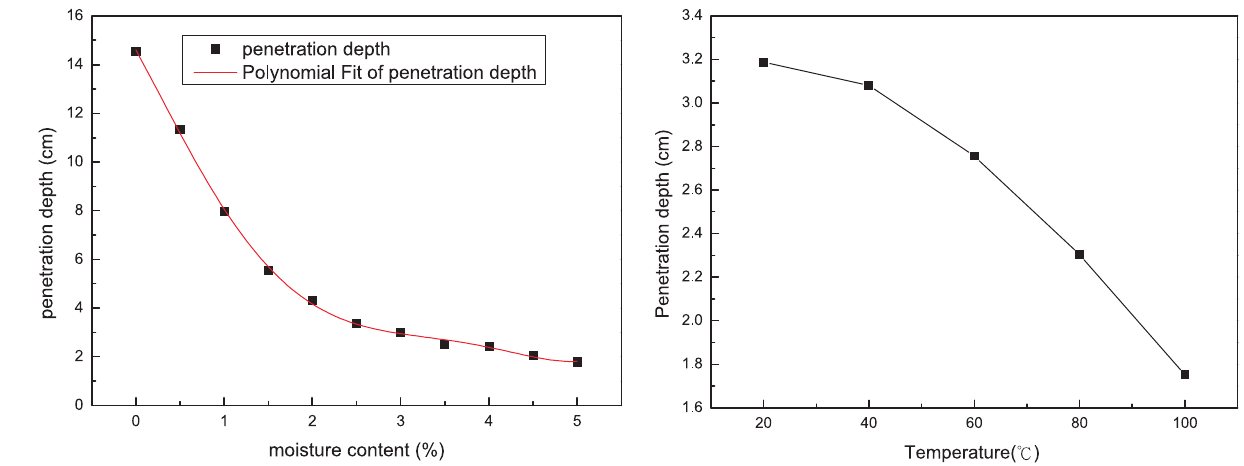
Fig. 9: Effects of moisture content on power penetration depth of sodium chloride at 2.45 GHz